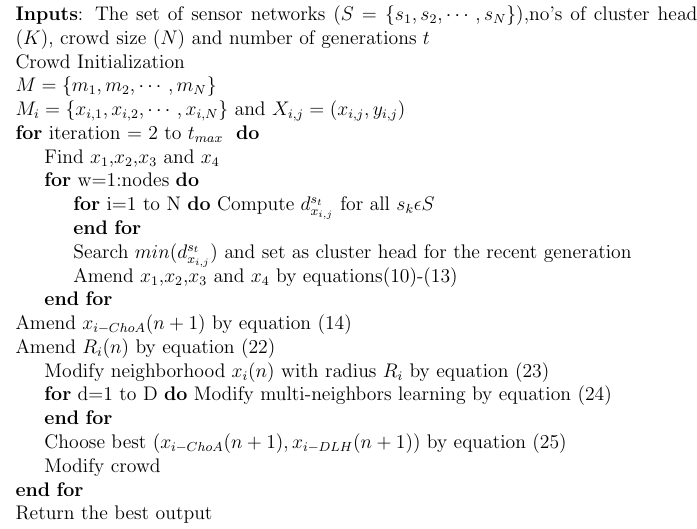
Algorithm 3 Pseudo-code of IChoA based cluster head selection algorithm